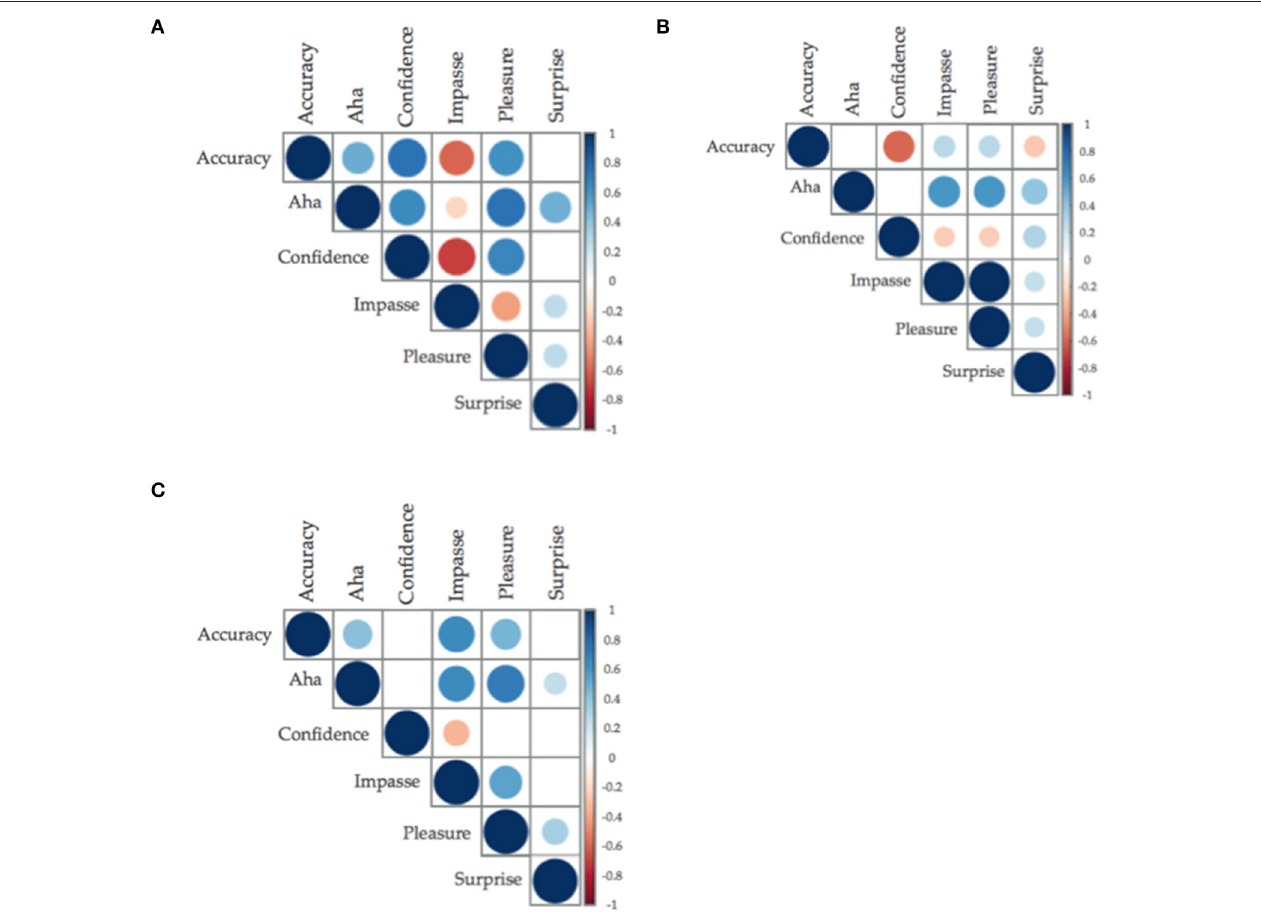
FIGURE 2 | (A–C) Correlation plots between accuracy and insight and insight related affect. Size of the circle and saturation of color determine the strength of the correlation; the color determined the direction of the relationship, with positive being blue ( A : classic insight problems; B : classic non-insight problems; C : compound remote associates. Only relationships with less than p = 0.05 have been